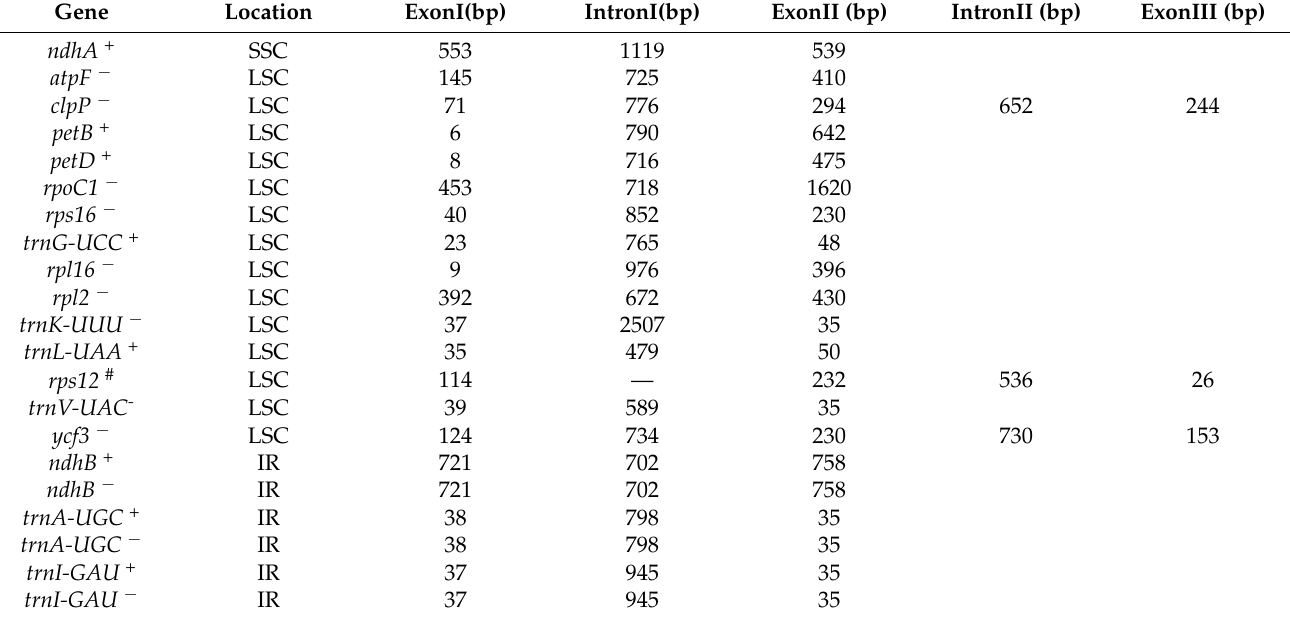
Table 2. Location and length of genes containing introns in M. chuanchienensis